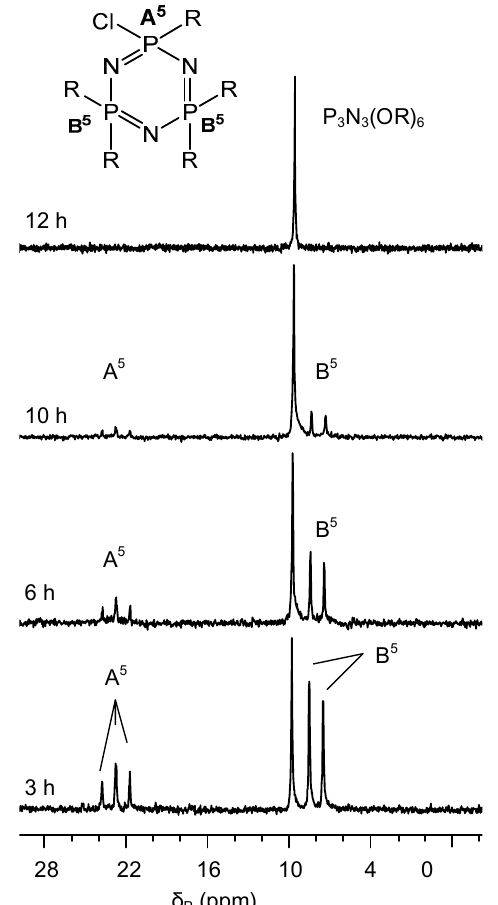
Figure 5. Changes in the 31 P NMR spectra of the reaction products of HCP and bisphenol A (1:24) with a process duration of 3–12 h.